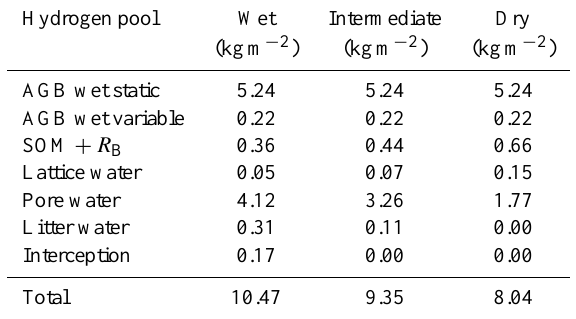
Table 8. Hydrogen pools (in kg hydrogen per m 2 ) in the CRS footprint for different moisture conditions (wet: 0.29m 3 m − 3 , full canopy and litter storage; intermediate: 0.17m 3 m − 3 , dry canopy and moist litter storage; dry: 0.05m 3 m − 3 ). Aboveground biomass is split into a static part (AGB wet static) comprising stems, branches and dry litter and a variable part (AGB wet variable) that represents leaves.